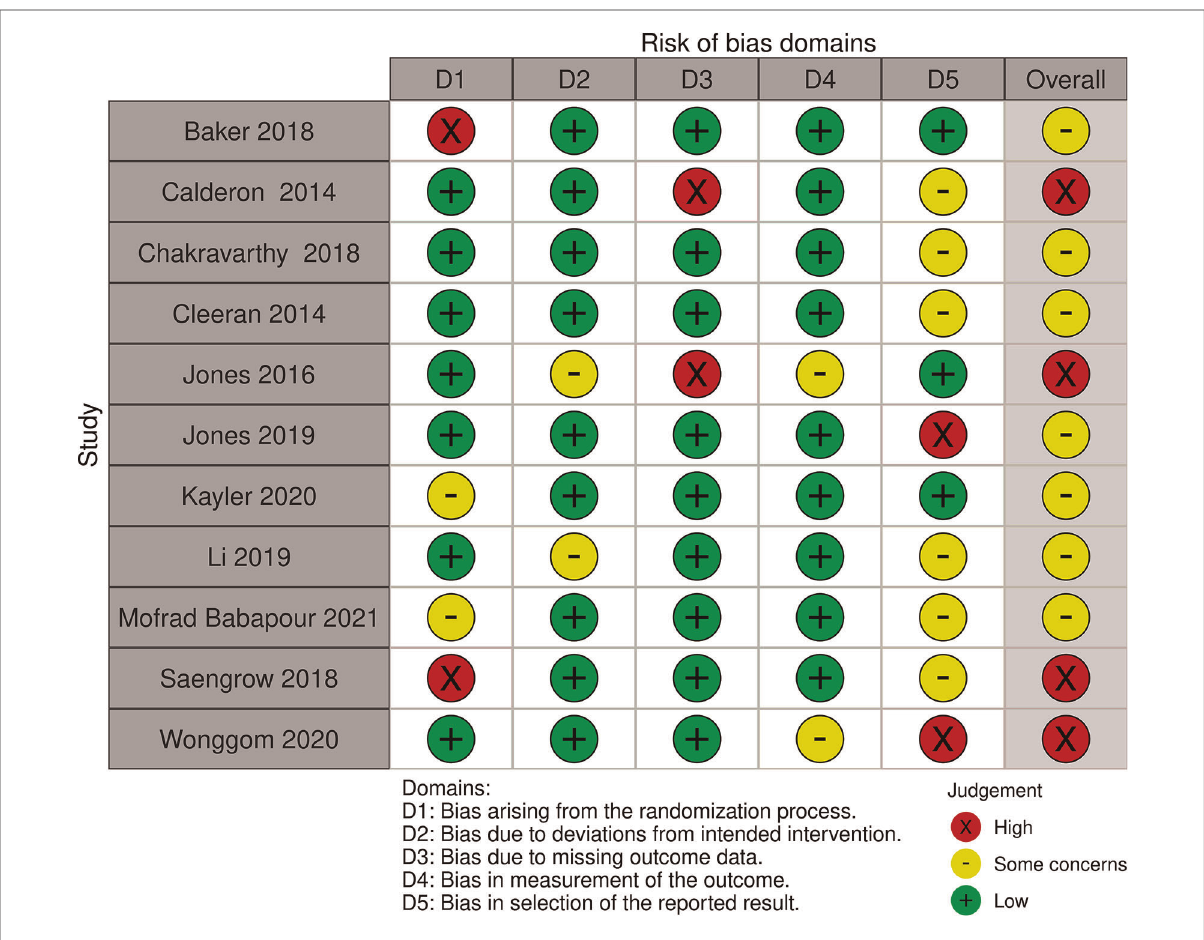
FIGURE 3 Risk of bias in the Category 2